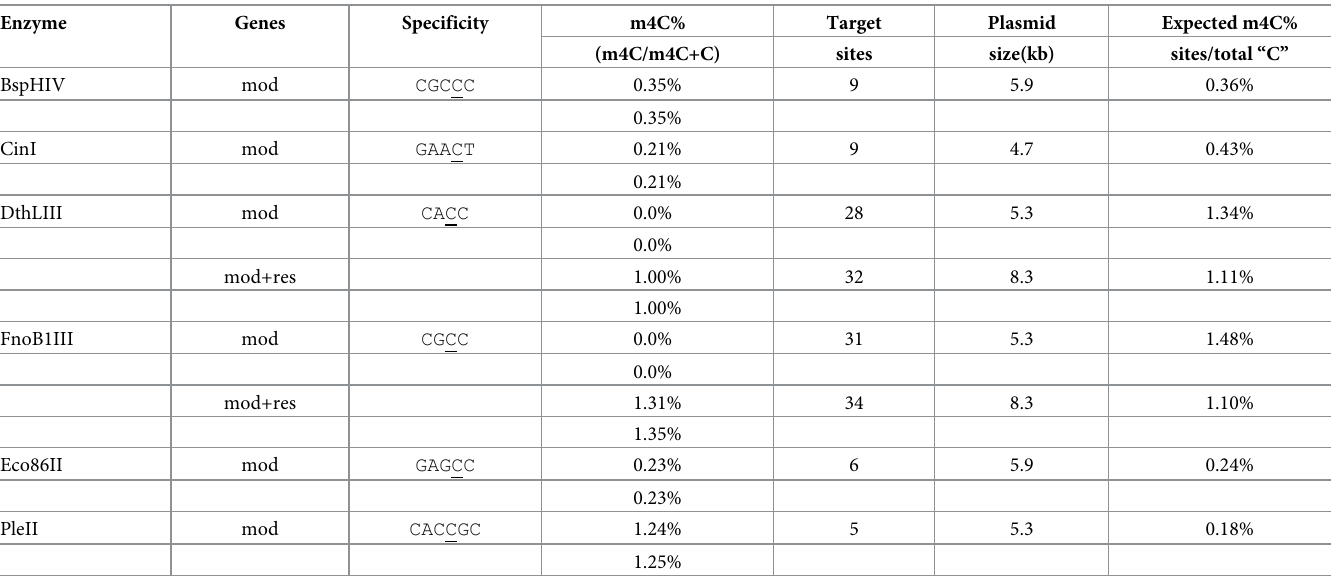
Plasmid DNAs expressing Type III mod genes were isolated from stationary phase cultures of E . coli C2523 ( dcm-/dam+ ). Two independent isolates of each plasmid DNA were hydrolyzed to nucleosides using the Nucleoside Digestion Mix and resolved and quantified using LC-MS. m4C percentage methylation data indicate the mean values for each pair of independent plasmid replicates. Expected m4C percentage indicates the percentage of recognition motif cytosine targets in the substrate plasmid. The methylated bases from each isolate are highlighted in bold text. Note that in the case of the two thermophilic isolates co-expression of both mod and res genes is required for expression of their cognate MTase